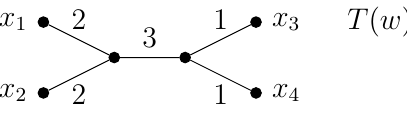
Figure 10: The restriction of d